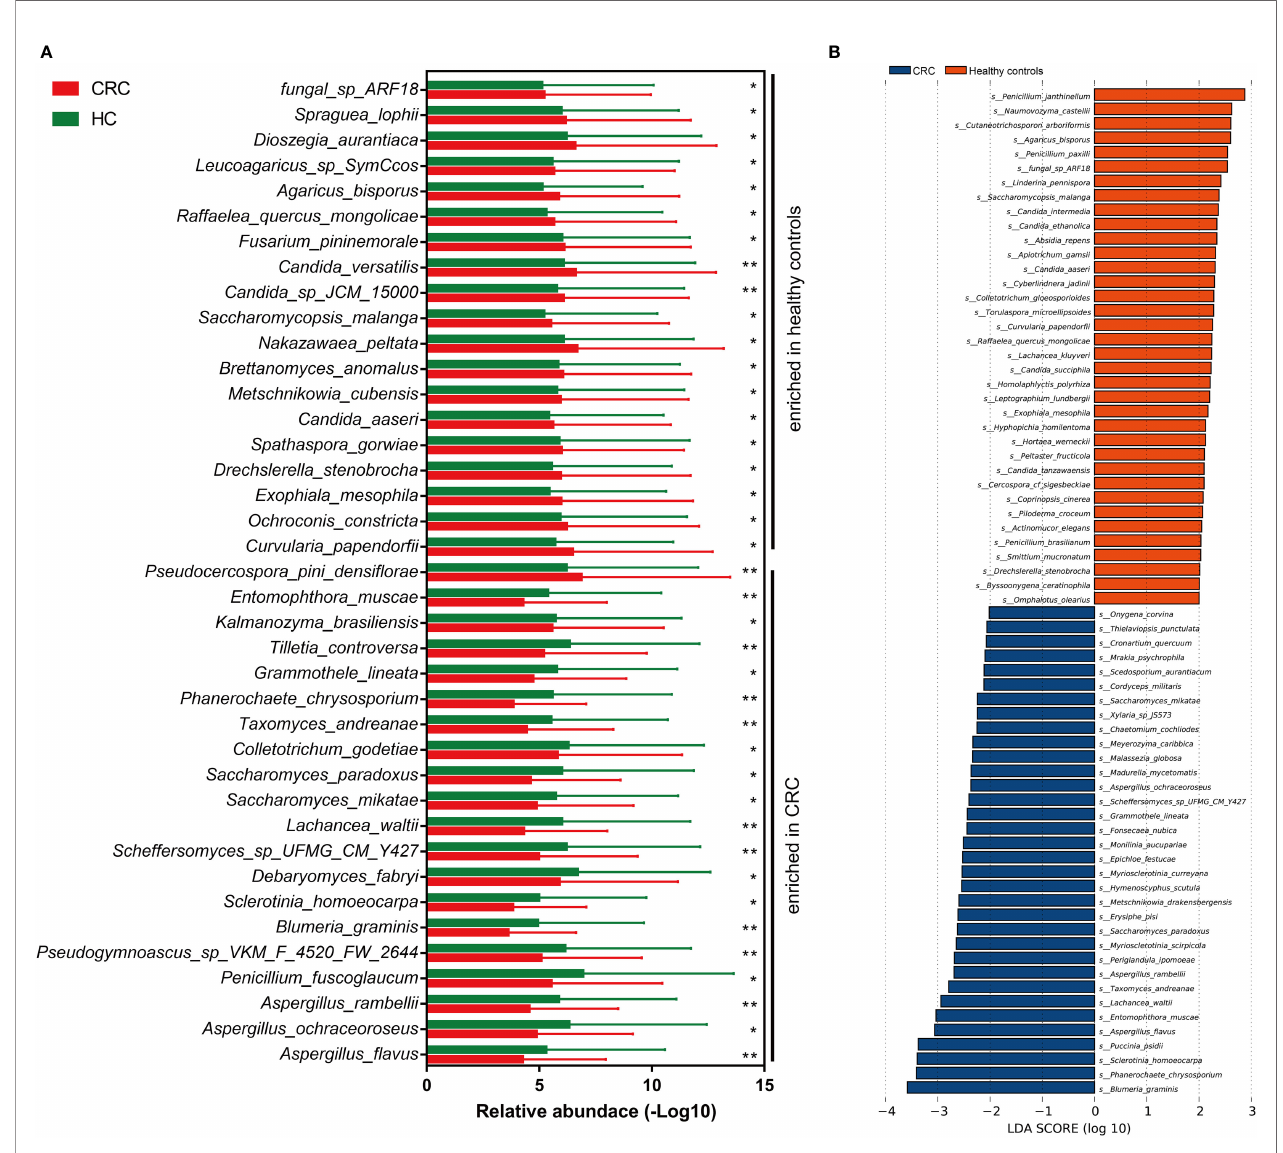
FIGURE 4 | The alteration of gut mycobiota signatures in colorectal cancer (CRC). The mycobiota pro fi les that were enriched in CRC and healthy controls by Wilcoxon rank-sum test (A) and linear discriminant analysis effect size analysis (B) . * p < 0.05; ** p <